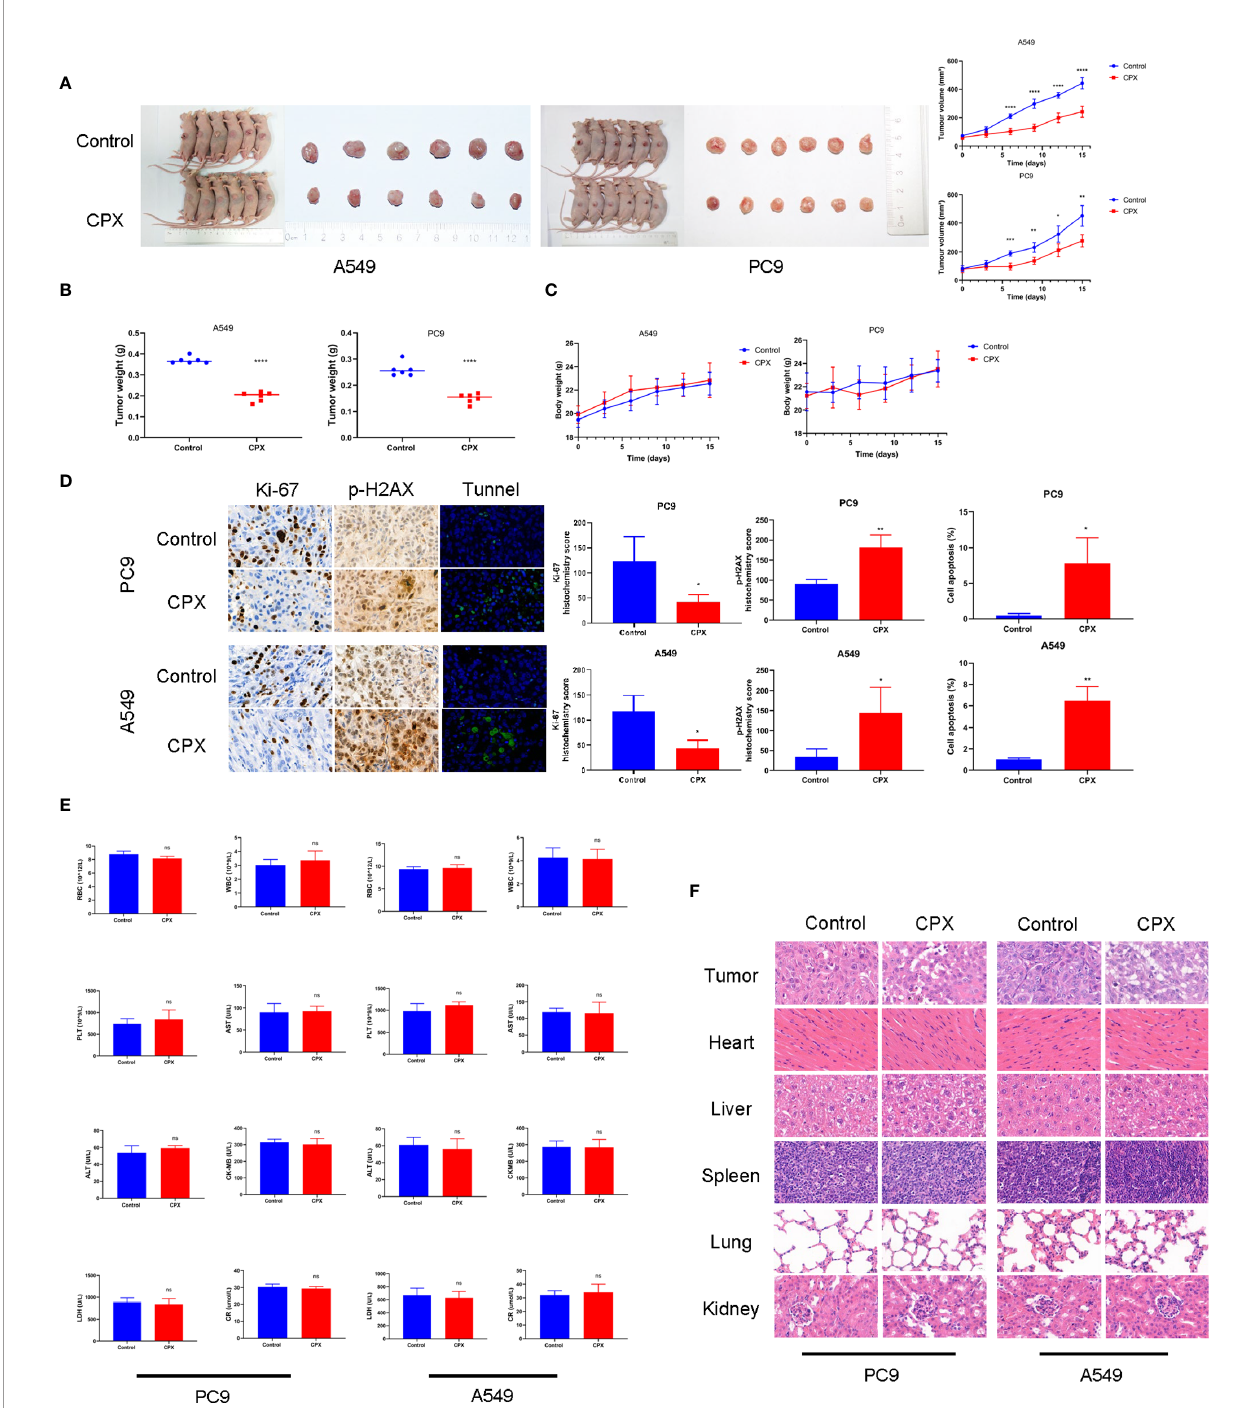
FIGURE 5 | CPX inhibits in vivo tumor growth without side effects. (A) Dissected tumor images from A549 and PC9 xenograft models. Tumor volumes were evaluated at indicated time points. (B) Tumor weights. (C) Bodyweight growth curves in xenograft models. (D) Immunohistochemistry showing Ki67and p-H 2 AX staining, and Tunnel assay of xenograft tumors (magni fi cation 400×). (E) Red blood cell (RBC), white blood cell (WBC), platelet (PLT) counts, aspartate aminotransferase (AST), alanine aminotransferase (ALT), creatine kinase isoenzyme (CK-MB), lactate dehydrogenase (LDH), and creatinine (CR) levels. (F) Representative hematoxylin & eosin images of mouse tumors and organs (magni fi cation 400×). *P < 0.05; **P < 0.01; ***P < 0.001; ****P < 0.0001, ns, non-signi fi cant. Statistical signi fi cance compared with respective control